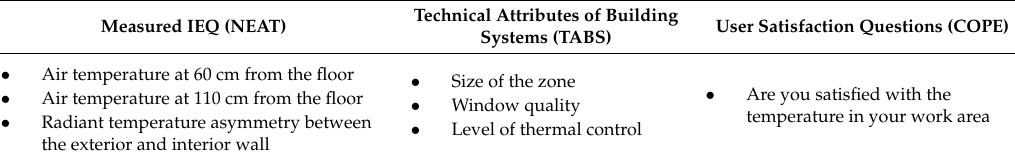
Table 17. Measured IEQ and technical attributes of building systems that significantly impacted user satisfaction on thermal quality.